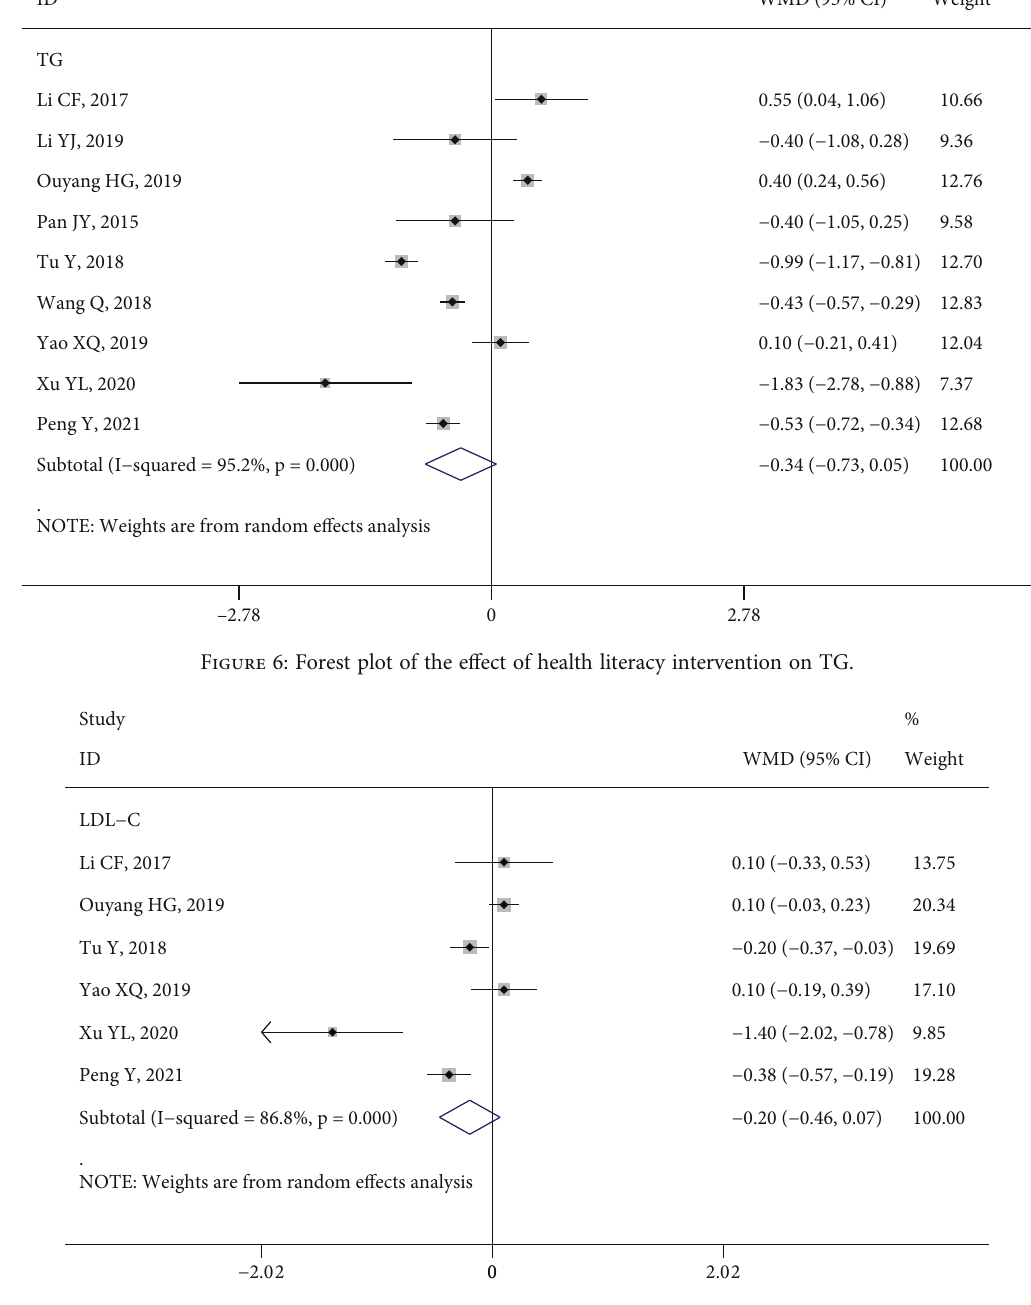
Figure 7: Forest plot of the e ff ect of health literacy intervention on